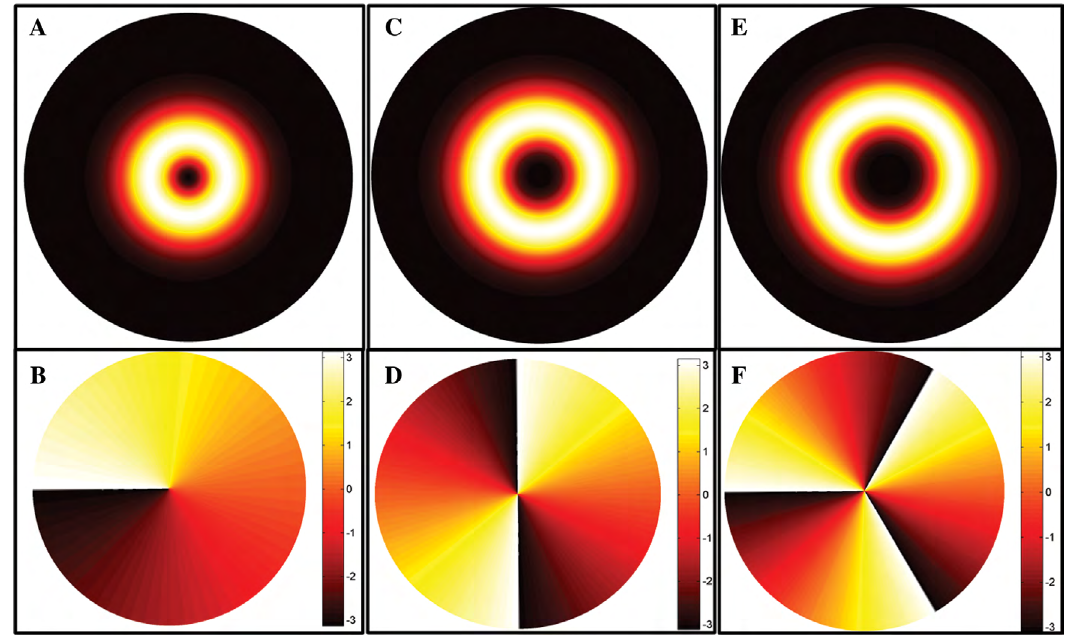
, LG and LG modes 01 02 03